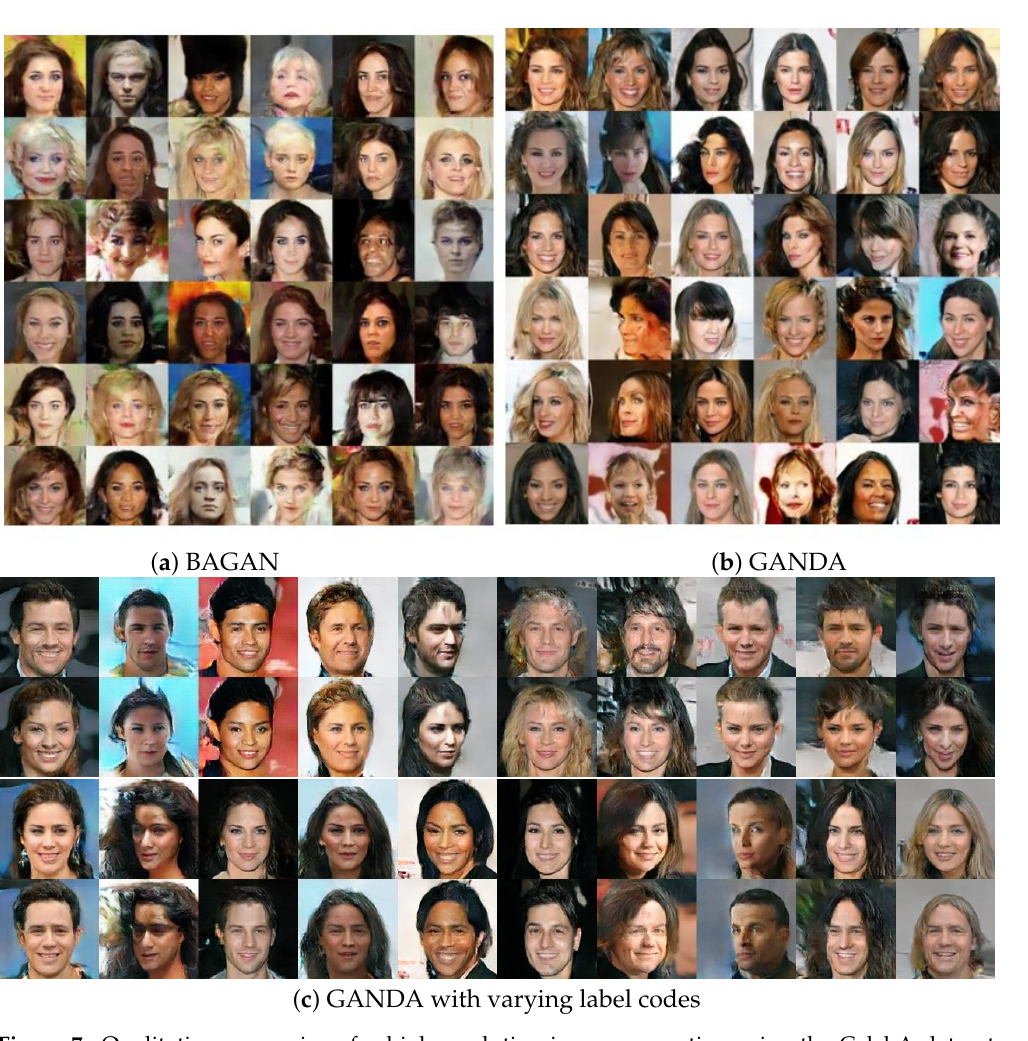
Figure 7. Qualitative comparison for high-resolution image generation using the CelebA dataset. ( a ) Samples produced by BAGAN for the minority class (female). There are some unintended class (male) samples. ( b ) Samples produced by GANDA for the minority class (female). All samples represent intended class (female) appearance. ( c ) Samples synthesized by varying the label code through the GANDA framework. The first two rows show samples by fixing z male ∼ N ( µ male , σ male ) and changing the one-hot label code c . The following third and fourth rows compare samples by fixing z female ∼ N ( µ female , σ female ) and changing the one-hot label code c